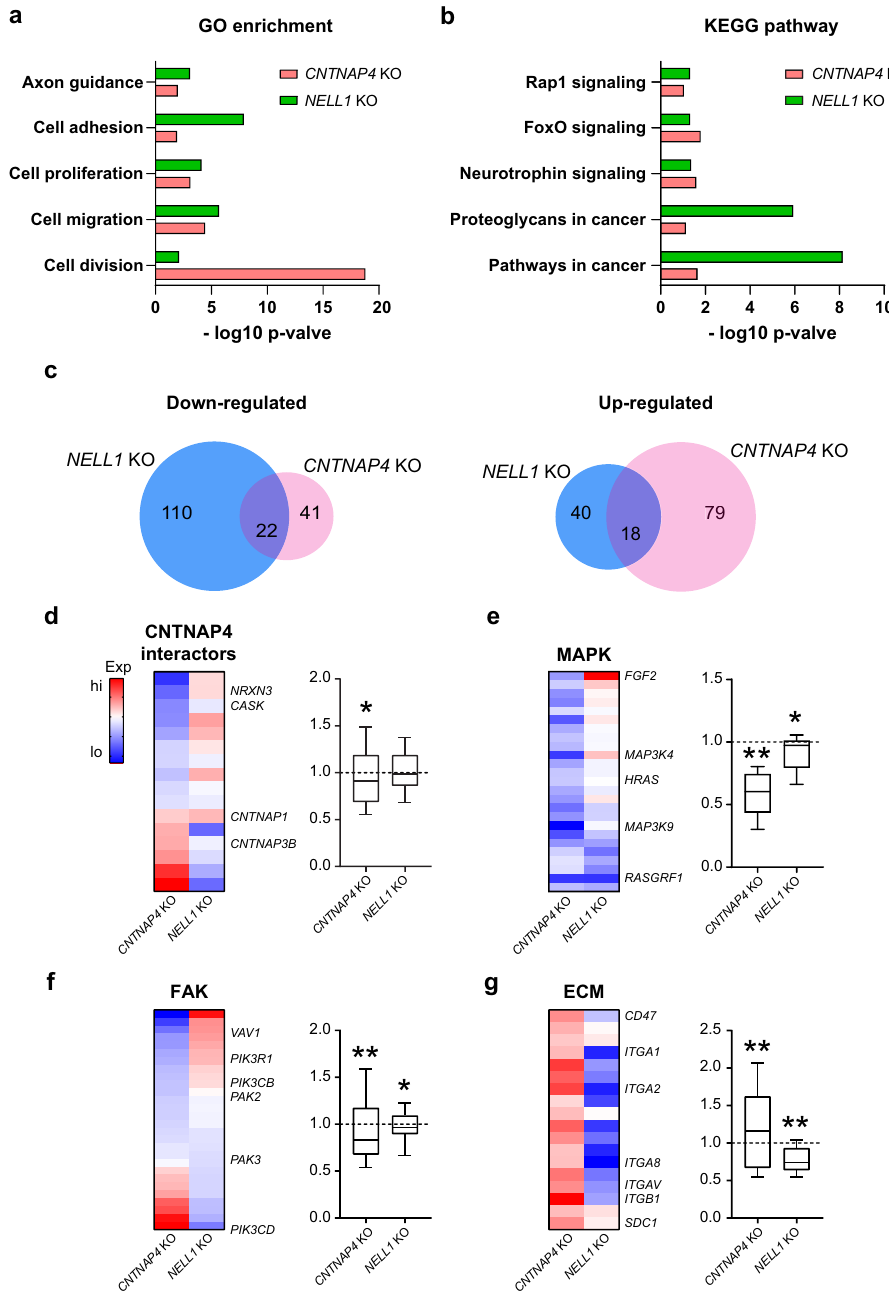
Fig. 5 Comparison of bulk RNA sequencing among CNTNAP4 KO and NELL1 KO OS cells. a – f Total RNA sequencing comparison between CNTNAP4 KO and NELL1 KO clonal 143B cells. a Gene Ontology (GO) enriched in both CNTNAP4 KO and NELL1 KO cells. b KEGG pathways enriched in both CNTNAP4 KO and NELL1 KO cells. c Venn diagrams show the similarities and differences in the signi fi cantly up- and down- regulated pathways between NELL1 KO (blue) and CNTNAP4 KO (pink) datasets ( P < 0.05). d – g Heat map demonstrating the contrast in the expression levels of genes involved in downstream signaling and corresponding module score among CNTNAP4 KO and NELL1 KO cells, including ( d ) CNTNAP4 interactors, ( e ) MAPK signaling, ( f ) FAK signaling, and ( g ) ECM-receptor interaction. Gene module scores are shown as a boxplot shows center line as the median, box limits as upper and lower quartiles of the modulus score. The dashed line indicates no change in gene module score in comparison to vector control. * P < 0.05; ** P < 0.01, in comparison to the corresponding vector control. demonstrate that CNTNAP4 signaling plays an important regulatory role in OS disease progression. These fi ndings suggest that targeted treatment of the Nell-1/Cntnap4 signal- ing axis represents a potential strategy to mitigate sarcoma disease progression.